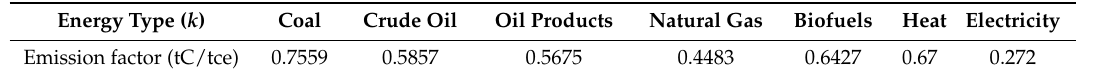
Table 3. Carbon emission factors ( K j ).